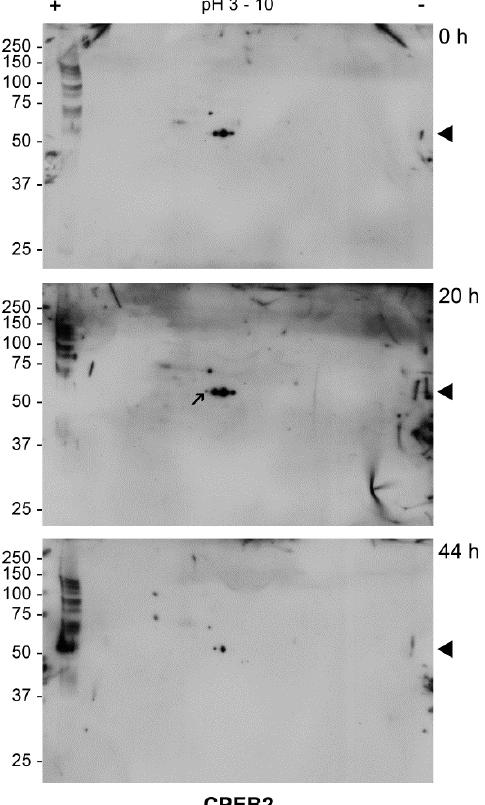
Figure 4. Detection of post-translational modifications of CPEB2 protein by 2DE Western blot. Two hundred immature (0 h) and matured (20 h and 44 h) oocytes were used per sample. Proteins were separated on a gradient of pH 3–10 using isoelectric focusing in the first dimension and then by SDS–PAGE in the second dimension. The arrow indicates the CPEB2 form with lowest pI. The experiment was performed three times. The black triangle indicates the molecular weight of CPEB2 protein.